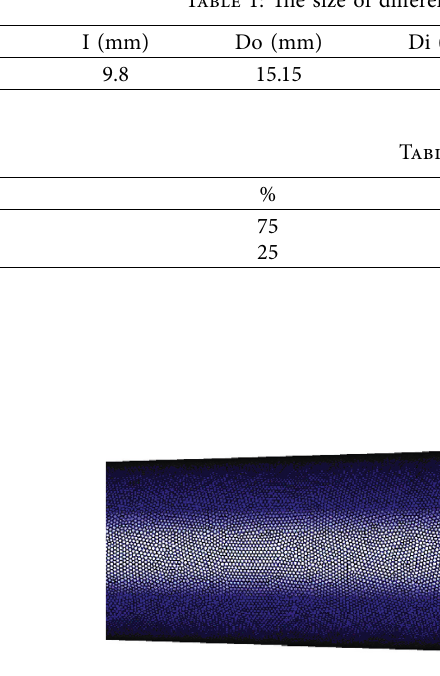
Figure 3: A view of the hydrocyclone mesh.